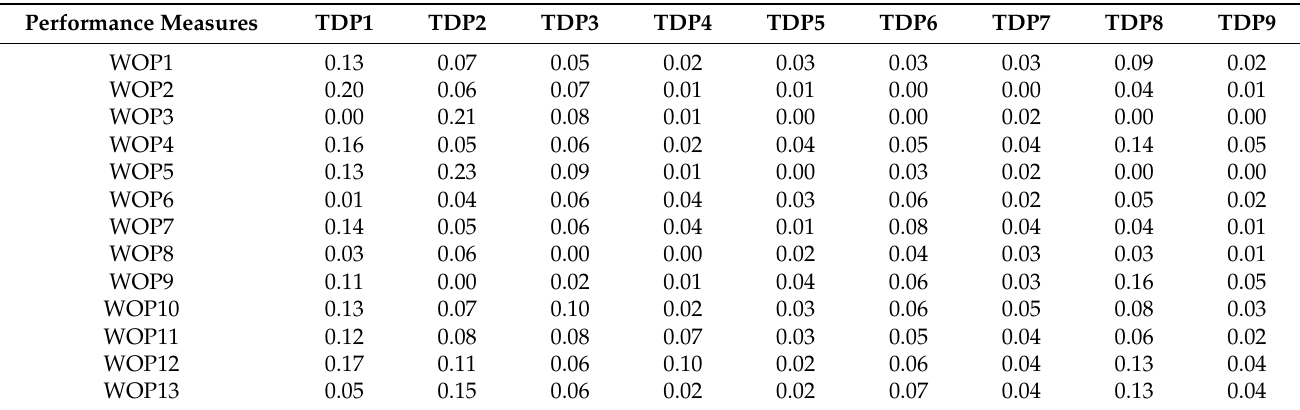
Table 11. Weighted comparability sequence